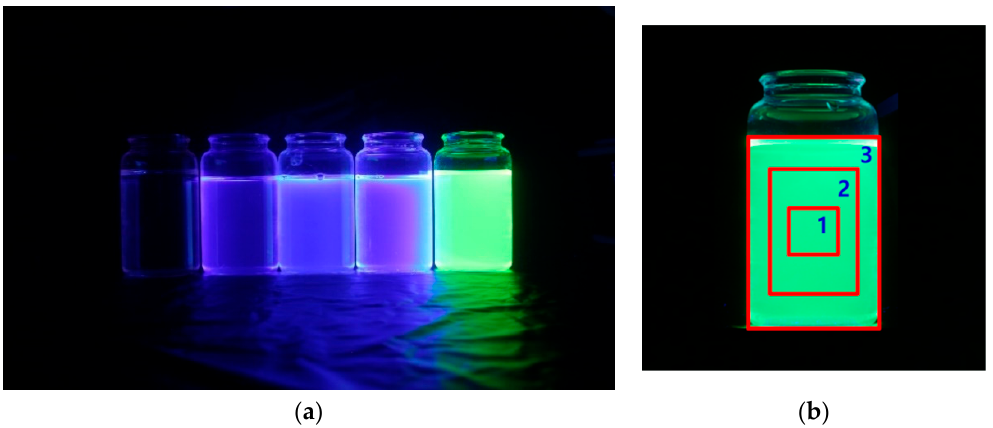
Figure 7. ( a ) Light is emitted from five samples illuminated by UV lamps. From left to right, pure water (H 2 O), PPO, POPOP, bis-MSB, and 6-FAM samples. Pure water did not emit any light. A cylindrical quartz container was filled with WbLS using Triton X100 surfactant. ( b ) Only those pixel regions with a V value above a certain level were selected, and their boundary lines were displayed as a rectangular box area. The first box whose V value was greater than 60% was selected for the background rejection.